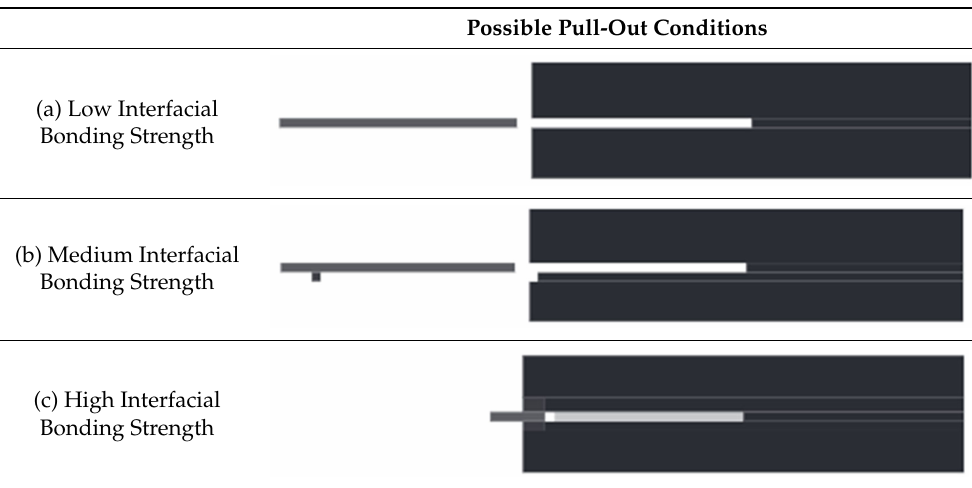
Table 6. Possible pull-out conditions due to different level of interfacial bonding strength